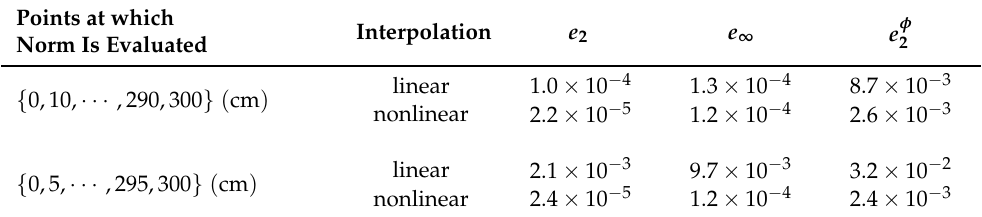
Figure 10. The first 4 POD basis functions for the group 2 scalar flux of LPOD. Leftmost plots, basis functions for layer 1 ( z ∈ [ 0,30 ] ) and rightmost plots, basis functions for layer 6 ( z ∈ [ 150,180 ] ). View of the xz plane with scaling applied in z . Table 5. Error in k eff and the scalar flux predicted by reduced-order model (LPOD) for the known ROM profile θ = 291°C and control-rod heights as stated. Values for both the linear and nonlinear interpolation are